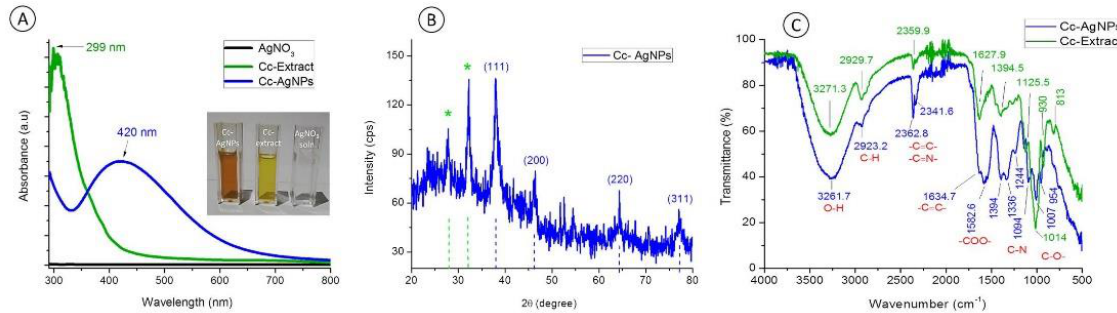
Figure 2. ( A ) UV – Vis spectra of AgNO 3 , C. colocynthis extract (Cc extract), and C. colocynthis silver nanoparticles (Cc − AgNPs). The inset shows the images of all three colloidal samples. ( B ) XRD pattern of Cc − AgNPs. Characteristic peaks confirmed the FCC crystalline structure of nanoparticles. ( C ) FTIR spectra of Cc extract and Cc − AgNPs show different absorption peaks pertaining to the existence of extract biomolecules on the surfaces of nanoparticles.